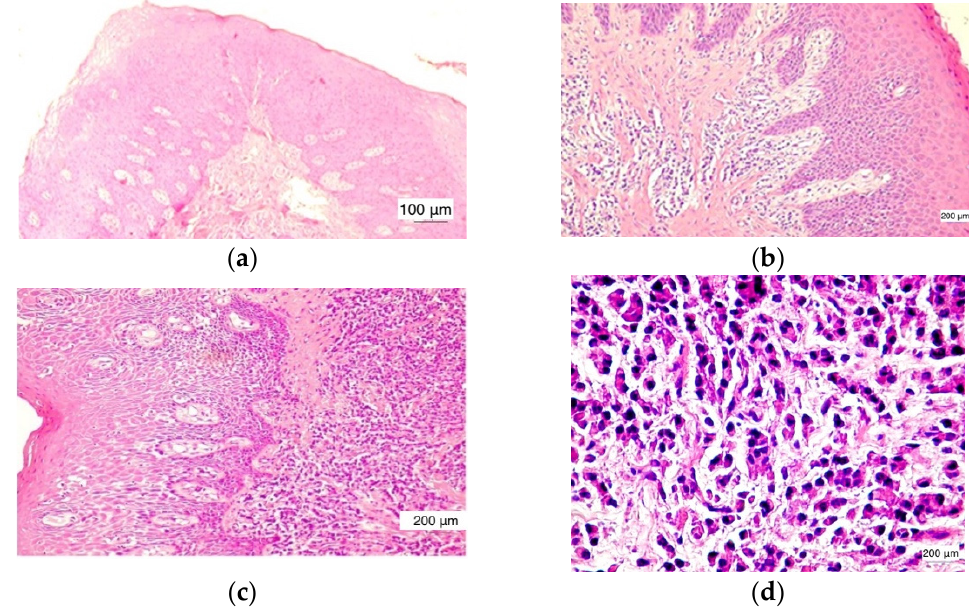
Figure 2. Different hematoxylin–eosin microscopic images for assessment of the morphological changes of the epithelium evaluation of the density of the inflammatory infiltrate: ( a ) gingiva with- out inflammatory changes GI = 0, ×200 magnification; ( b ) inflammatory infiltrate in the lamina pro- pria with focal distribution, epithelium without modification GI = 1, ×200 magnification; ( c ) inflam- matory infiltrate in the lamina propria, intraepithelial lymphocytes GI = 2, ×200 magnification; and ( d ) inflammatory infiltrate with polymorphic cellularity GI = 3, ×400 magnification.